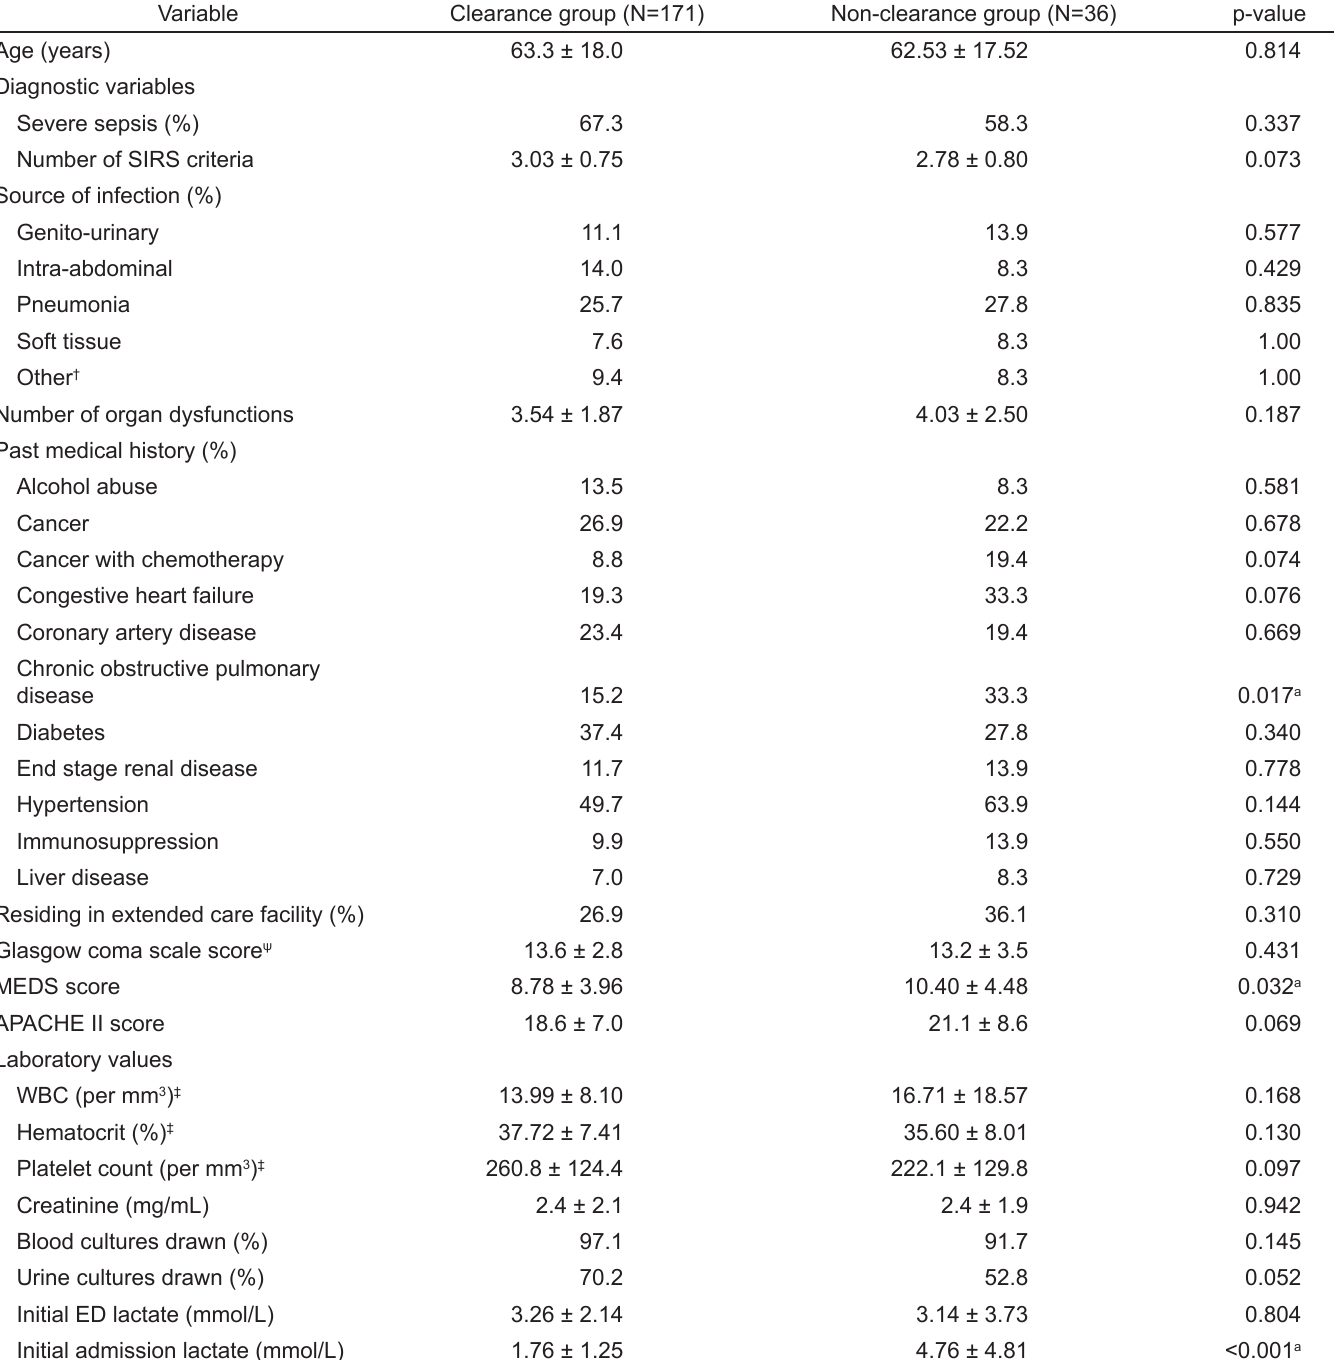
Table 3. Baseline characteristics and therapies for clearance and non-clearance